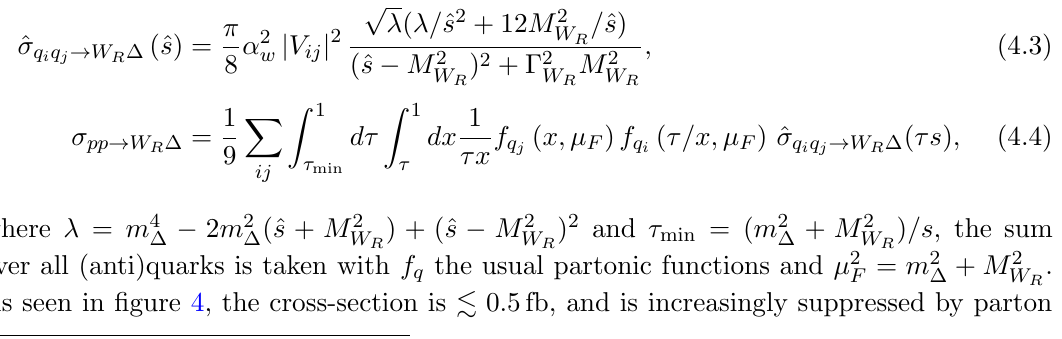
= p R = 3 ; 4 ; 5 TeV and s = R